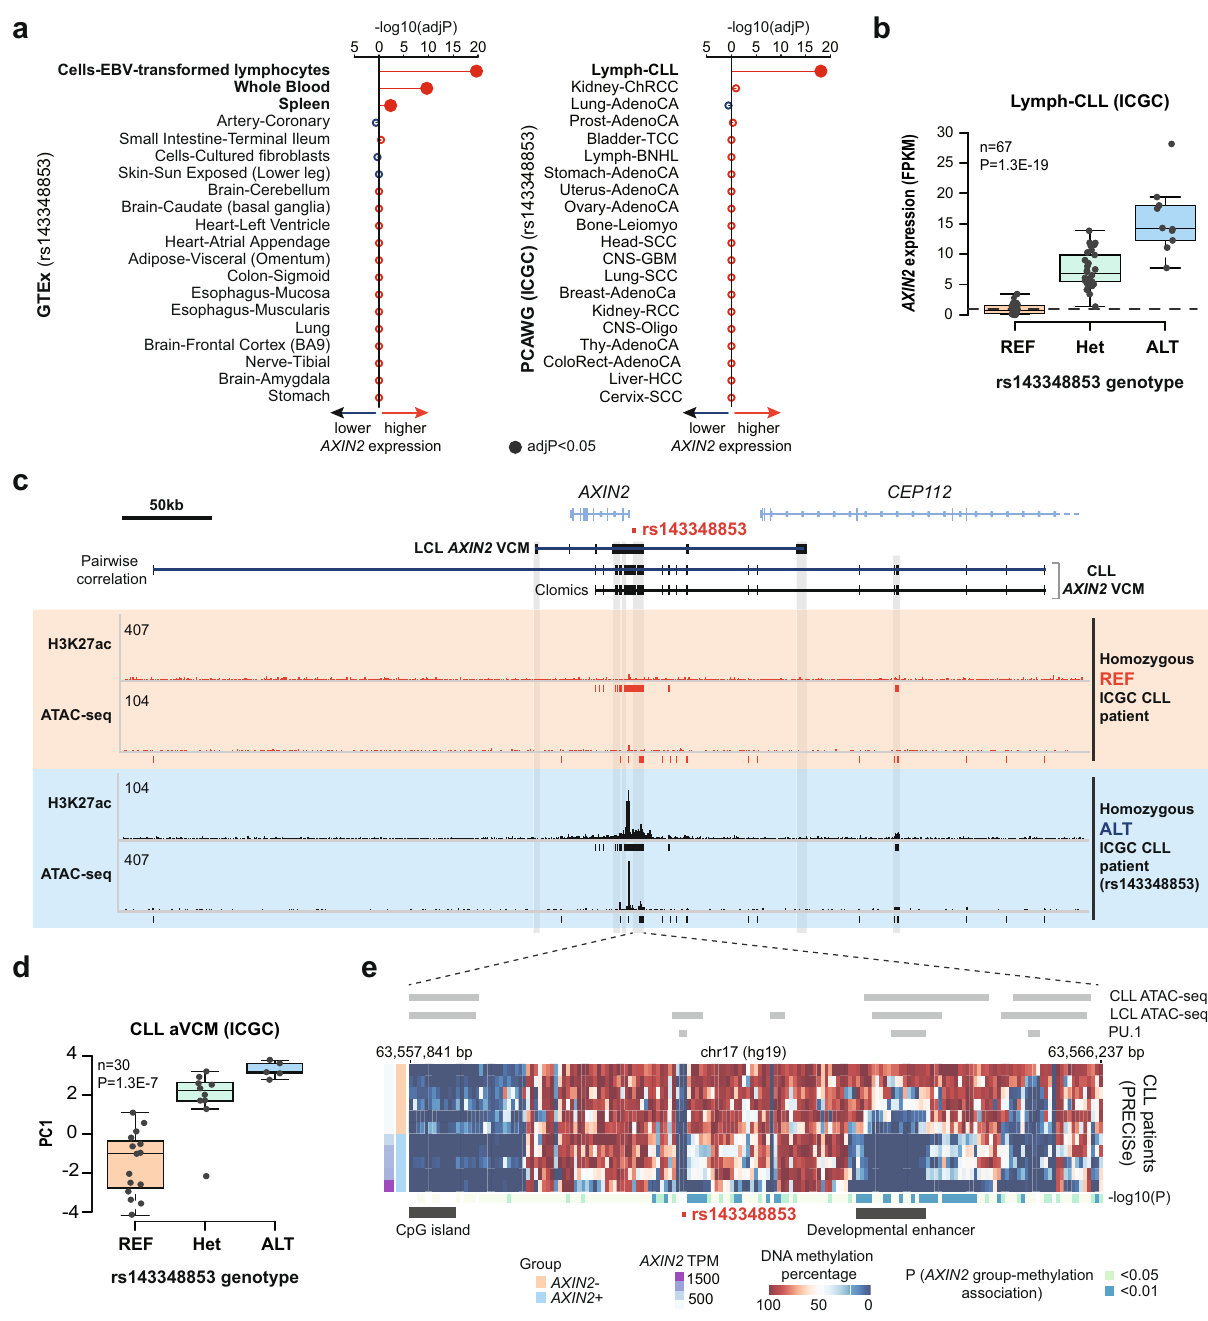
Fig. 2 The AXIN2 -rs143348853 eQTL is highly cell-type-speci fi c. a AXIN2 -rs143348853 eQTL analysis on 49 GTEx tissues (left panel) (only the top 20 tissues based on the nominal p- value are shown) and on 20 cancer types from the PCAWG project (right panel) (cancer abbreviations as provided in the original study 26 ). The GTEx nominal p -values and effect size (normalized effect size, NES) were obtained from the GTEx portal. The PCAWG p -values and effect size were obtained from a linear regression model. Signi fi cant hits (Bonferroni adjusted p -value (adjP) < 0.05) are denoted in bold. b AXIN2 expression from CLL patient lymphocytes from the PCAWG project according to the rs143348853 genotype. c Genomic view of the AXIN2 locus showing the CLL VCM structure based on the two different calling methods) and H3K27ac and ATAC-seq signal pro fi les from two different CLL cell populations, representing the rs143348853 homozygous REF and ALT genotypes. Meta peaks are displayed below each track. The considered LCL and CLL enhancers, based on high H3K27ac signal, are marked with gray boxes. d aVCM measured by the fi rst principal component analysis value (PC1) on all correlated molecular phenotypes (H3K27ac and ATAC-seq) embedded in the CLL AXIN2 VCM, as called using the pairwise correlation method. e DNA methylation on the indel-enhancer from several CLL cells based on WGBS. Cells are grouped based on AXIN2 mRNA expression (A XIN2 + and − , which corresponds to high and low AXIN2 expression, respectively). AXIN2 expression in transcripts per million (TPM). CLL and LCL ATAC-seq and LCL PU.1 peaks are displayed. CpG island coordinates were obtained from the UCSC Genome Browser. The region found to be in the top 5000 most hypomethylated regions in later stages of B cell development compared to NBCs 29 (i.e., developmental enhancer) is also denoted. n and P indicate the number of considered patients and nominal p- value from a linear regression model, respectively. For b and d , boxes indicate the IQR (25 – 75%) and the box center indicates the median. Whiskers represent de minimum or maximum values of no further than 1.5 times the IQR for both the top and bottom of the